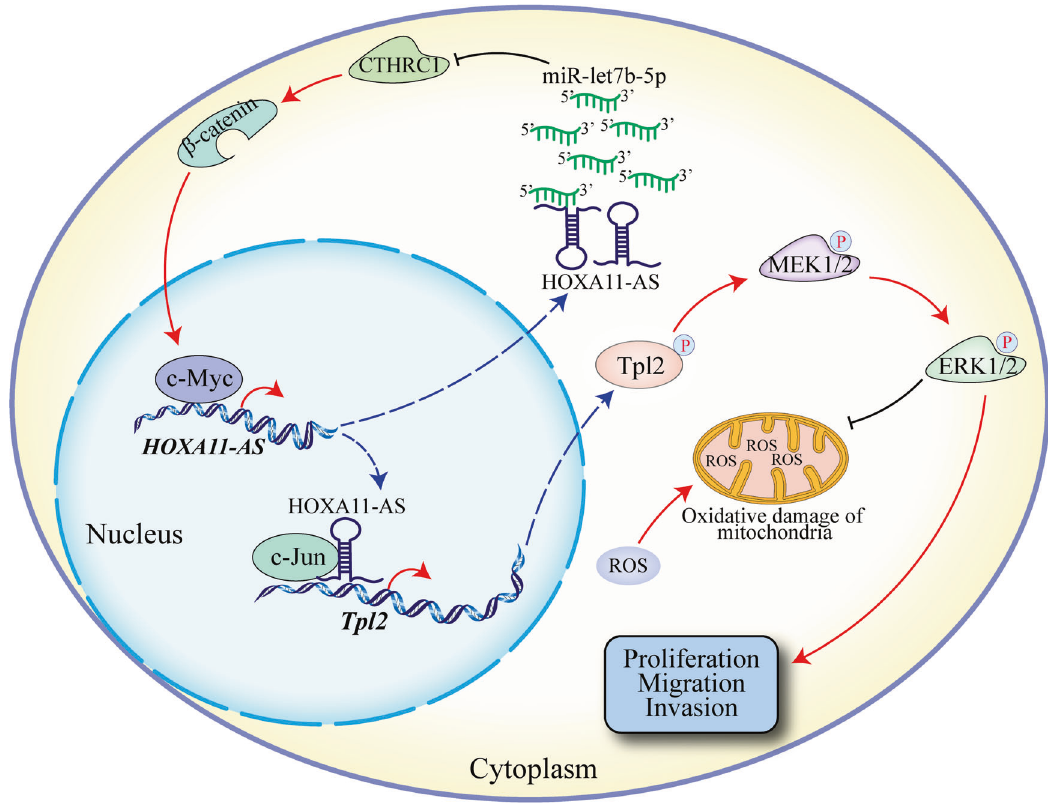
Fig. 7 The main mechanism diagram of this study. A schematic illustrated the abnormal expression of HOXA11-AS in glioma and the mechanism of HOXA11-AS regulating the sensitivity of glioma cells to